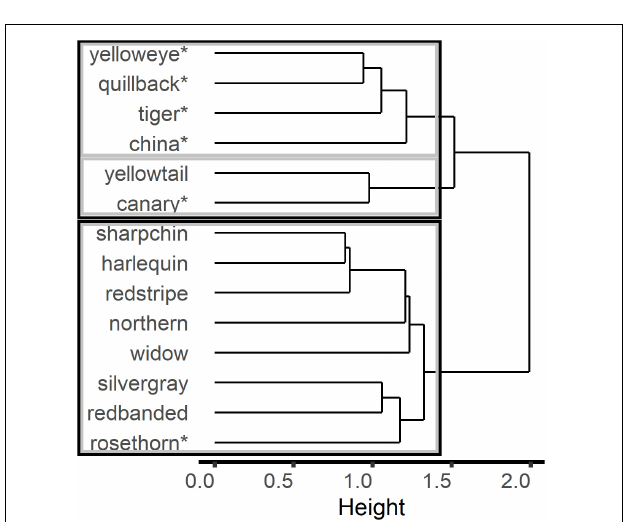
FIGURE 4 | Results from Ward’s hierarchical cluster analysis using the proportions matrix with “units” (year-month-subarea-gear) in R-mode where 2 (black lines) or 3 (gray lines) clusters are supported by the bootstrap resampling method. The “*” indicates species that currently belong to the Demersal Shelf Rockfish complex.